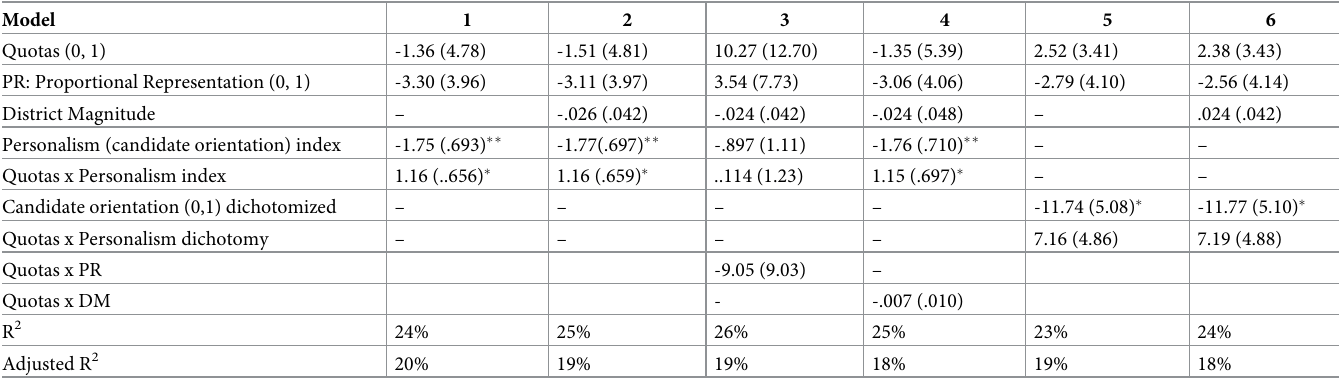
Table 1. Women’s representation in parliament (pooled).